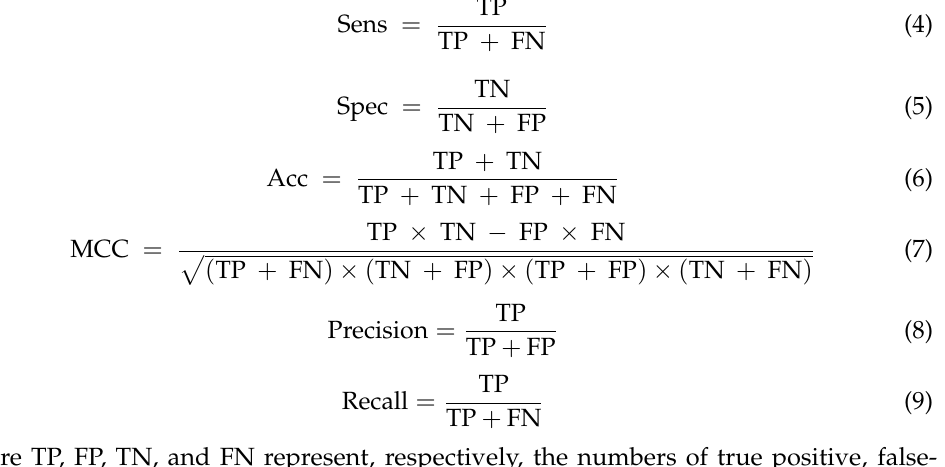
samples on training dataset; Figure S2: AUC values for different window sizes based on 10-fold cross-validation tests; Figure S3: AUC value with respect to selected features for the five encoding schemes; Table S1: Prediction performance after the removal of 30% sequence redundancy on the training dataset; Table S2: Fifteen types of AAI properties used in this